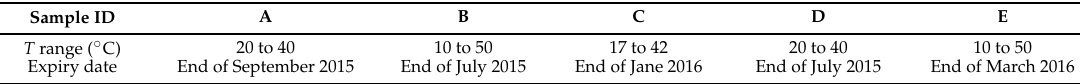
Table 1. Working temperature range and expiry dates of the five pastes studied. Sample ID